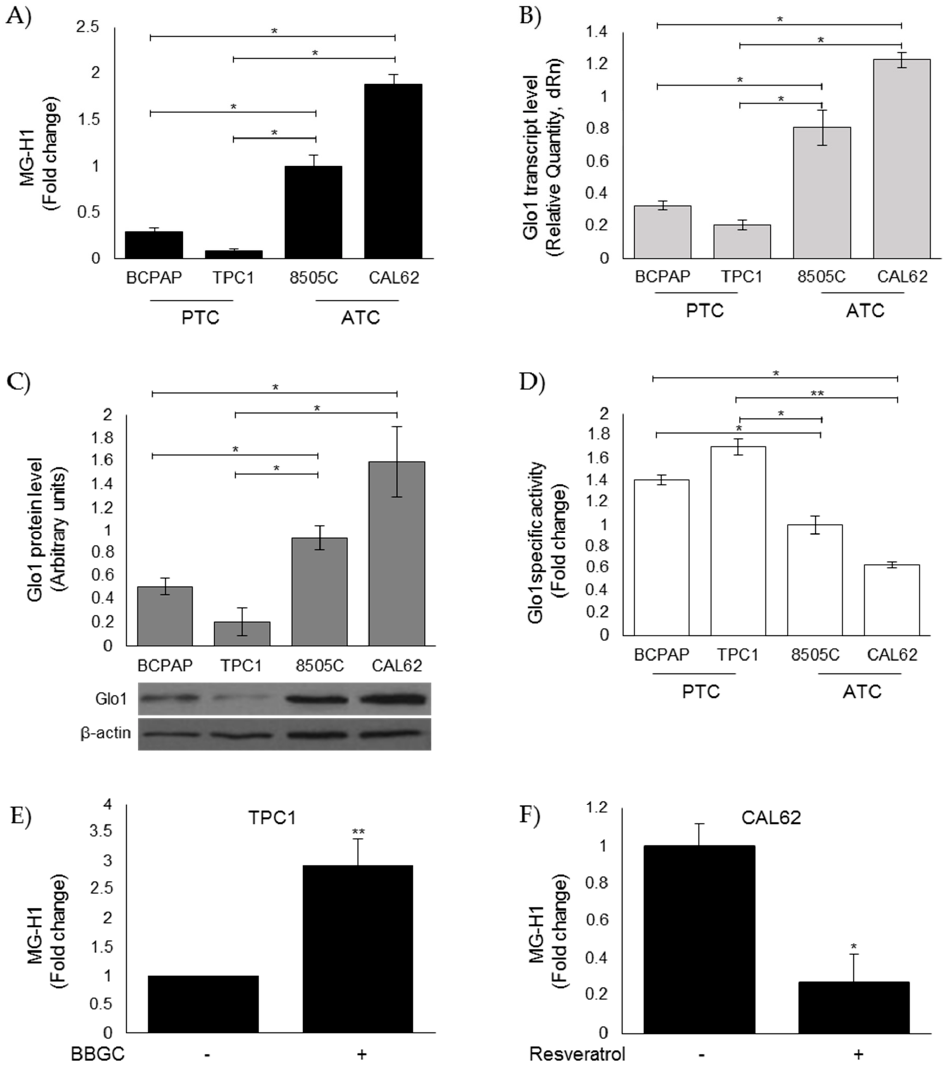
Figure 3. Evaluation of MG-H1 and Glo1 expression in human thyroid cancer (TC) cell lines. PTC (BCPAP and TPC1) and ATC (8505C and CAL62) cell models grown to confluence under standard